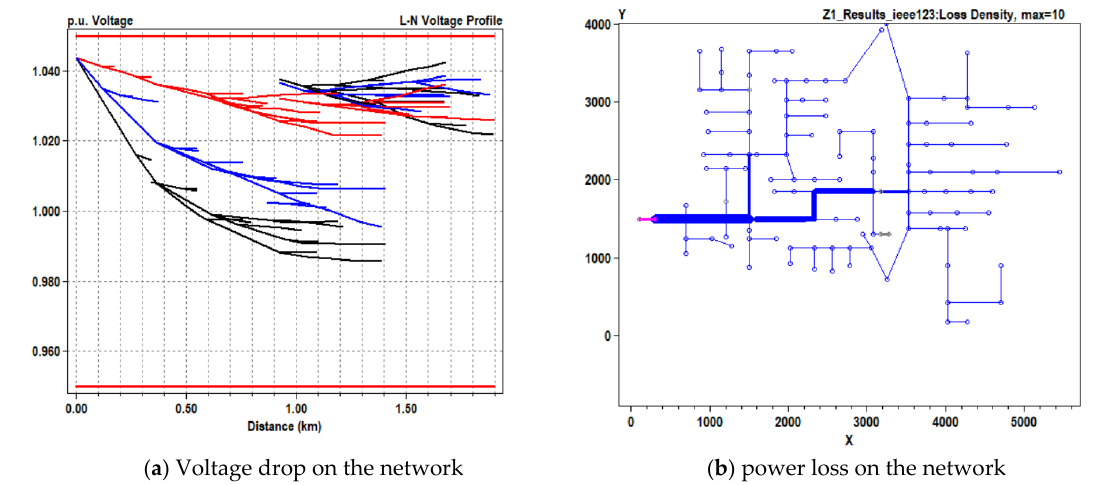
Figure 14. Impact of EVPL with PV system #5 on the distribution network. ( a ) Voltage drop on the network, ( b ) power loss on the network.